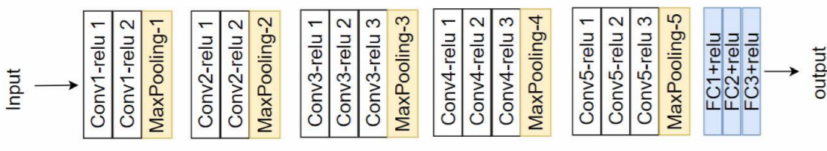
Figure 13. VGG 16 network architecture [98].